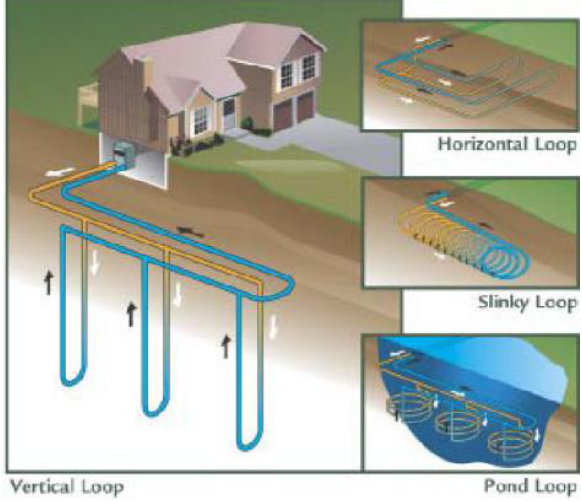
Figure 1: Geothermal heat pump in a closed circuit and thermal bathing ground and lake [3,